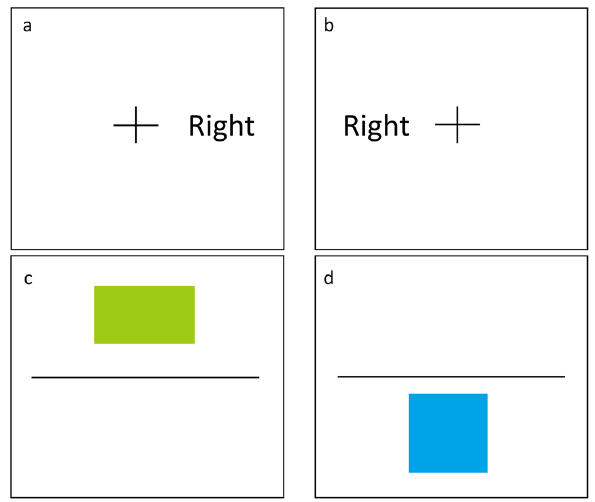
Figure 4. An example of the choice-RT task ( a ), the Simon task ( b ), and the alternate task-switching task ( c , d ) (figure created using Microsoft